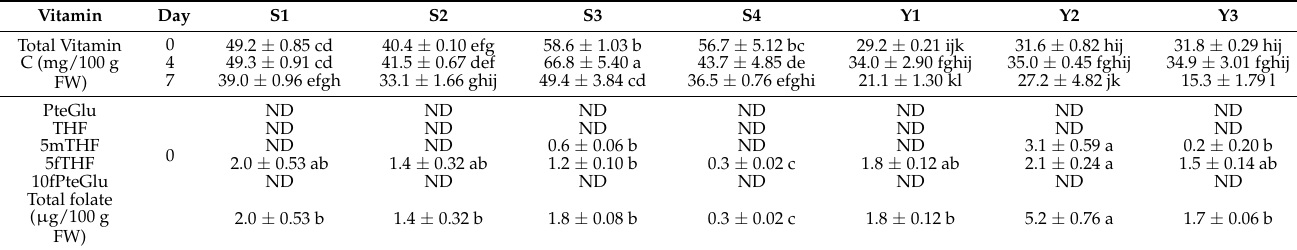
Table 5. Vitamin C and folate in the studied